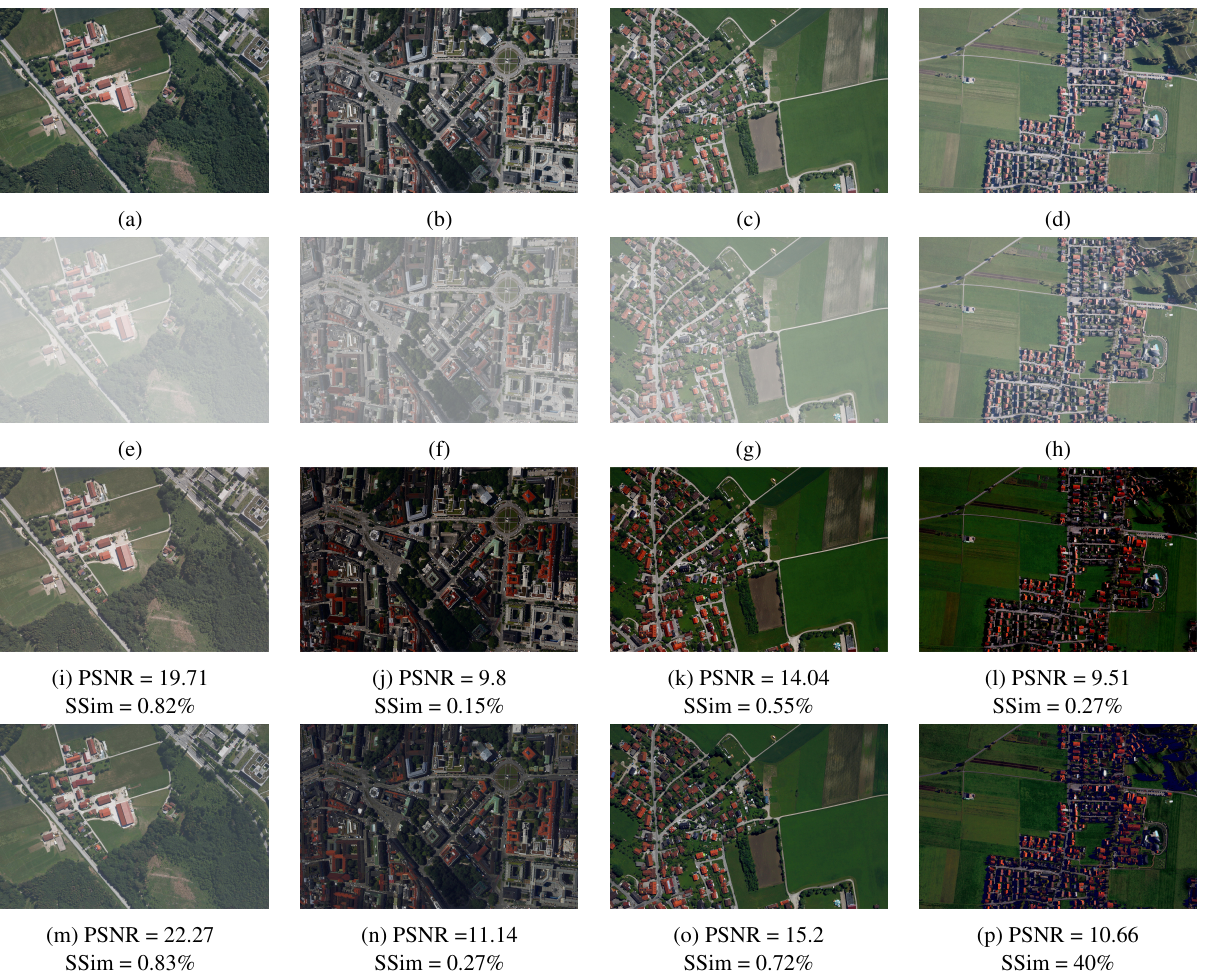
Figure 6: Ground truth images, together with their hazy and dehazed versions. The first row: Haze-free images, the second row: Hazed version of the same images in different levels, the third row: Dehazed images using AOD-Net which is trained on NYU dataset, and the fourth row: Dehazed images using adapted